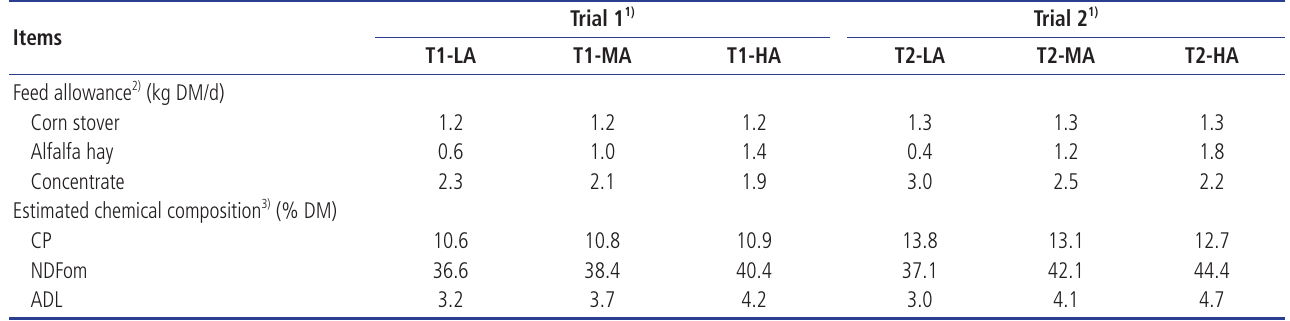
Table 2. Feed allowances and chemical composition of experimental diets formulated for Simmental beef calves